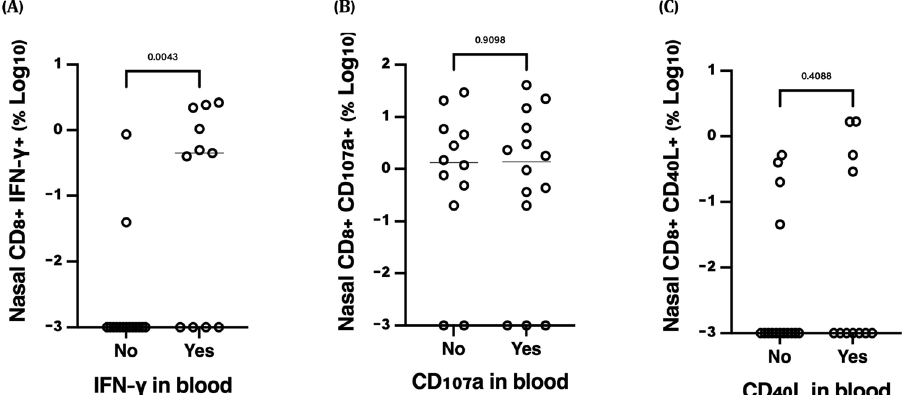
Fig. 5 Nasal-blood correlations between background-subtracted SARS-CoV-2 spike-speci fi c CD8 + T cell responses ~6 months post-vaccination. Nasal immune cells isolated from ( n = 24) participants, were stimulated with overlapping spike-speci fi c peptides or left unstimulated for ~16 h. Nasal CD8 + T cell responses for ( A ) IFN- γ , ( B ) CD107a, and ( C ) CD40L are shown, strati fi ed by whether a positive response for that readout was detected in matched blood. Blood responses below detected were imputed as “ 0.001 ” for graphing purposes. Unpaired non-parametric Mann – Whitney test was